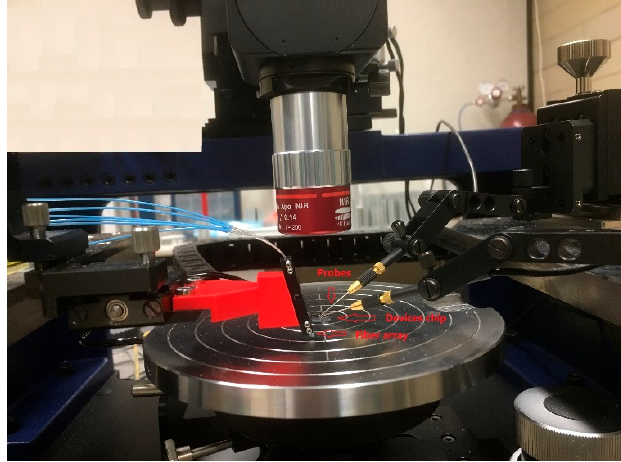
Figure 7. Transimpedance amplifier constructed by lateral bipolar junction transistors (LBJTs) and JFETs.